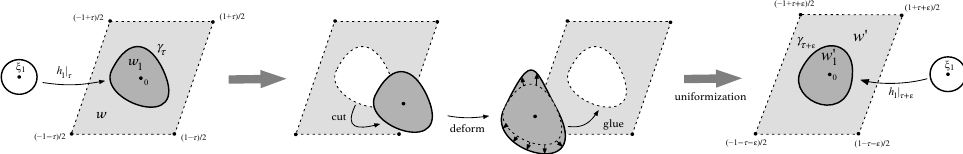
Figure 6 . Picture illustrating the use of the Schi(cid:11)er variation to deform the tadpole surface state from (cid:28) to (cid:28) + (cid:15) . The size of the local coordinate patch is exaggerated relative to (cid:12)gure 5 to aid